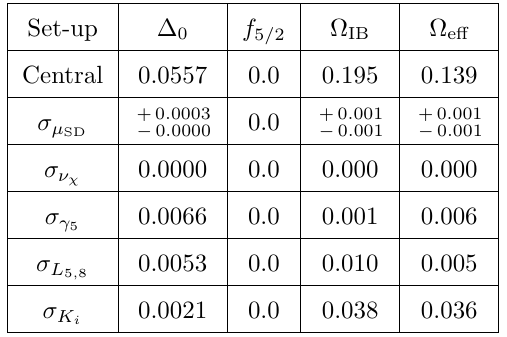
Table 14 . LO central values for (cid:11) 6 = 0 and their parametric